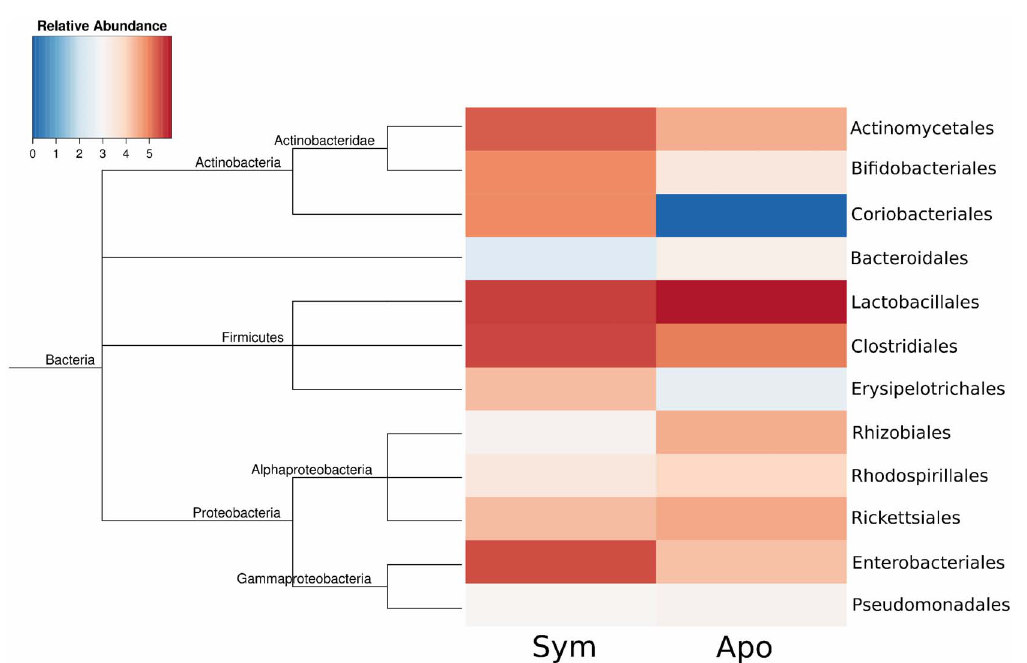
Fig. 1. Heatmap of the sum of mapped reads (logarithmic scale) on bacterial transcripts annotated as the depicted taxonomic groups. The tree on the left represents the phylogenetic relationships of the bacteria based on the NCBI database.